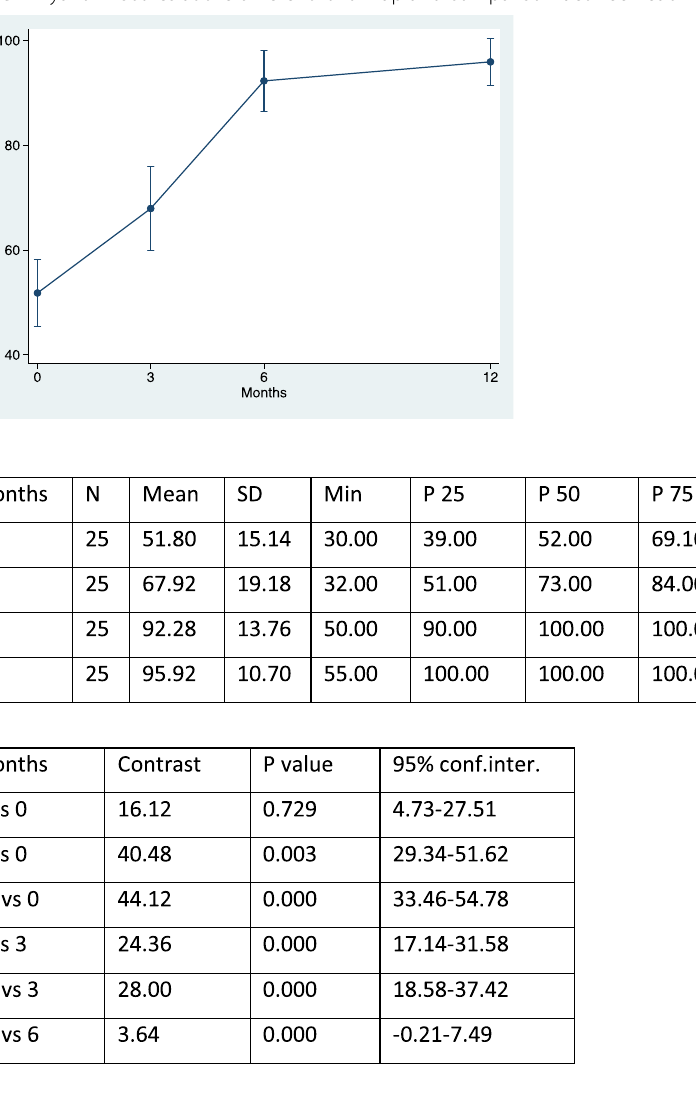
Table 4 Lysholm scores at the different follow up and comparison between each